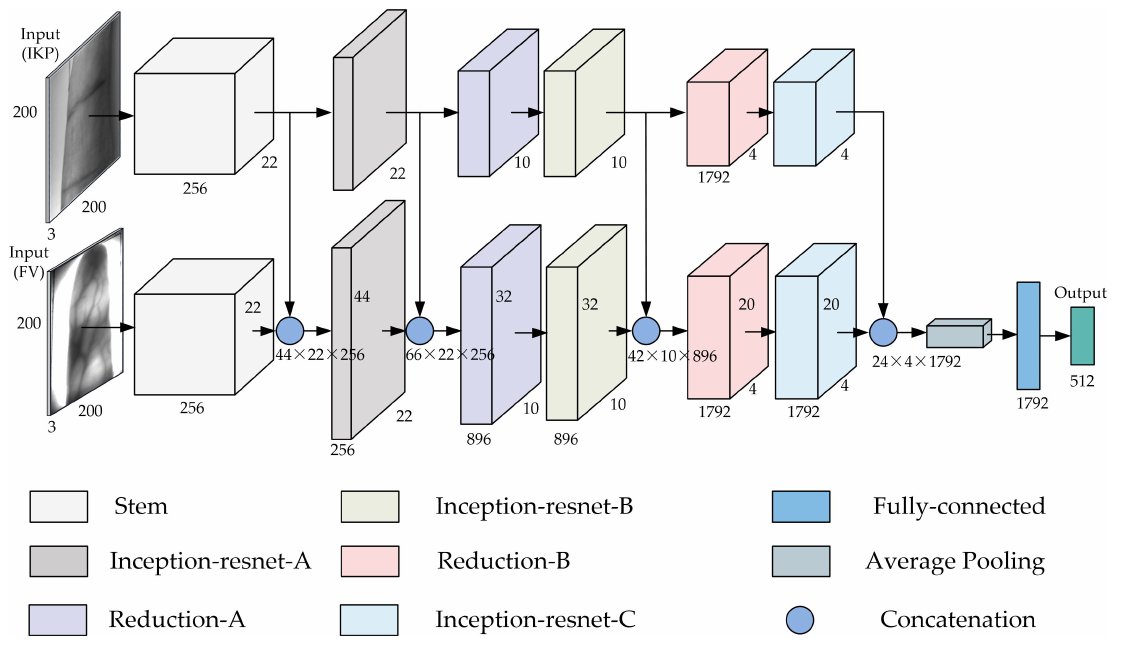
Figure 3. Dual-Branch-Net network